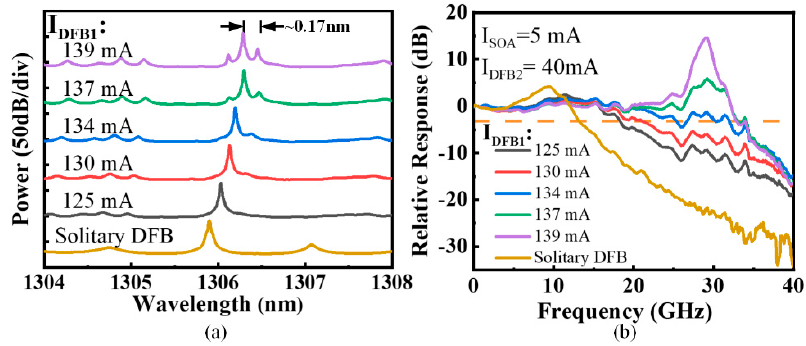
Figure 6. ( a ) Lasing spectra and ( b ) corresponding small-signal modulation response of the solitary laser (brown line) and the IMC laser with different I DFB1 values. Here, I DFB2 and I SOA of the IMC laser were fixed at 40 and 5 mA, respectively.